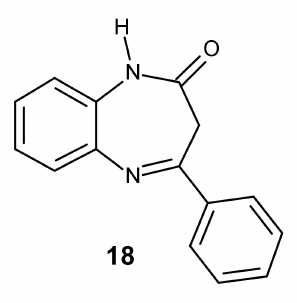
Figure 27. Compound 18 with the best neuroprotectant profile.